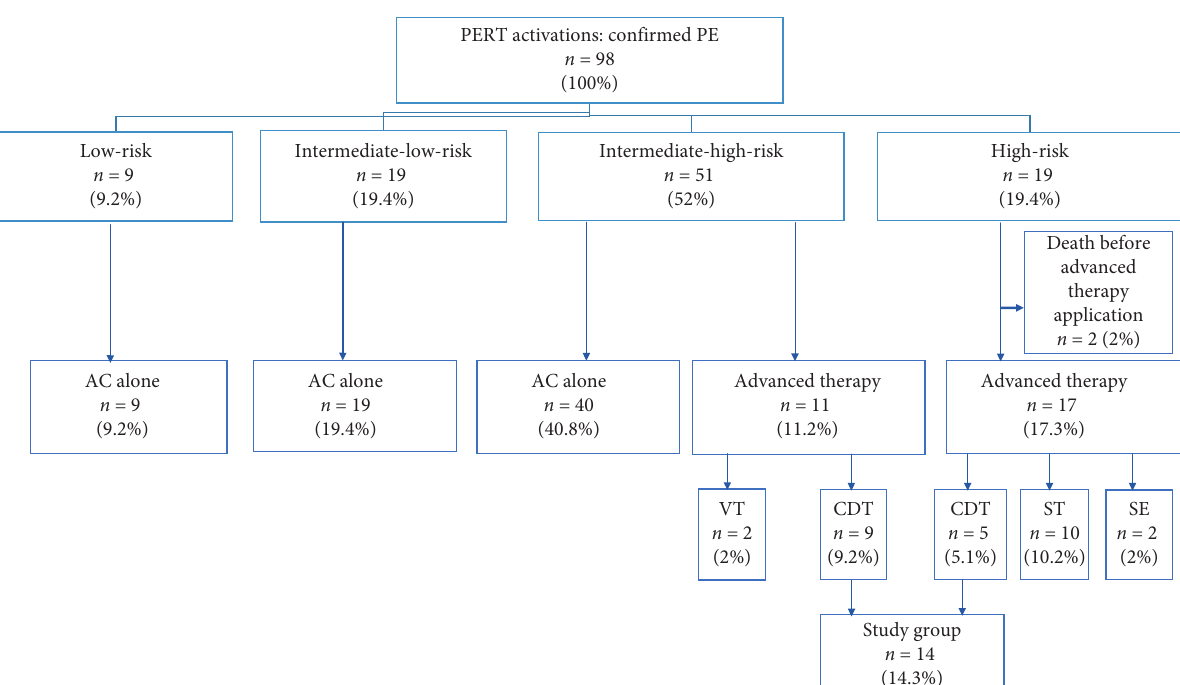
Figure 1: Detailed risk stratification of patients with PE and applied treatment modalities by our institutional PERT. AC � anticoagulation, advanced therapy � anticoagulation together with CDT or SE, ST, or VT, CDT � catheter-directed mechanical aspiration thrombectomy, PE � pulmonary embolism, PERT � pulmonary embolism response team, SE � surgical embolectomy, ST � systemic thrombolysis, and VT � venous thrombectomy.